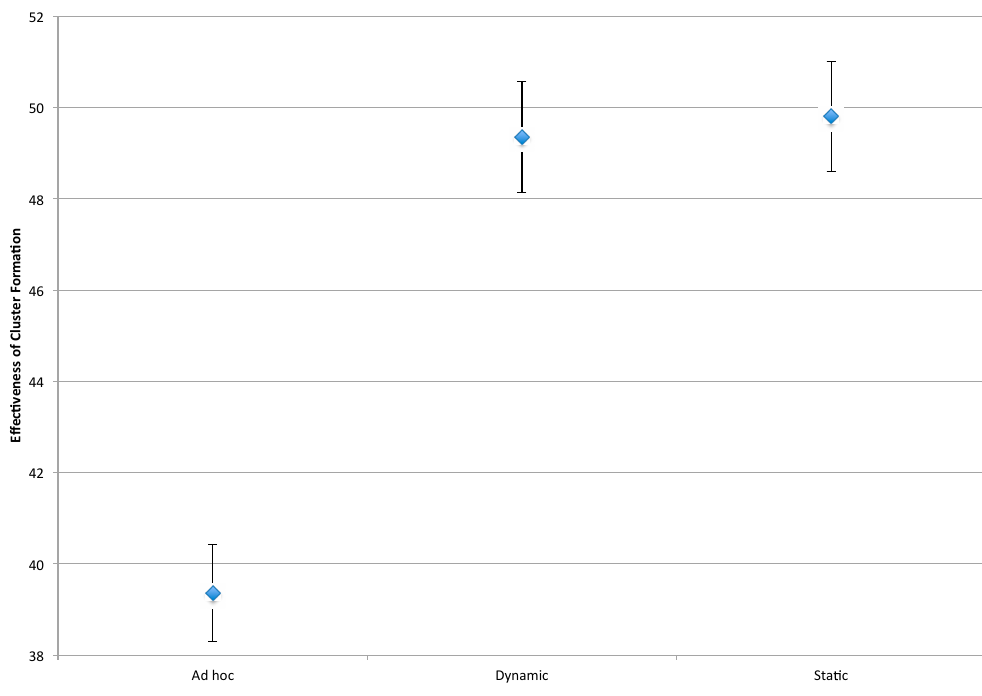
Figure 9. Interval plot for effectiveness. n = 160, ANOVA, 1 df , p < 0.05.